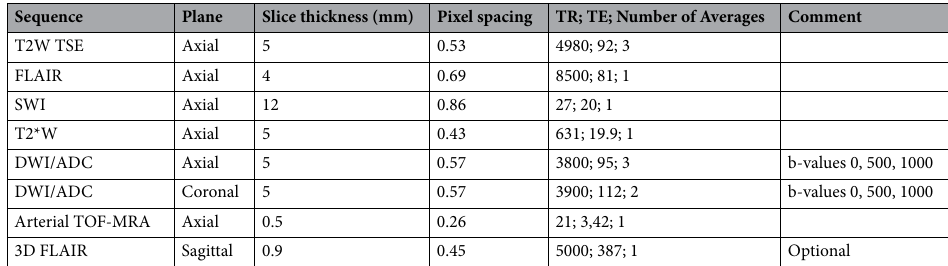
Table 1. MRI sequences for the late follow-up imaging. T2W T2-weighted, FSE fast spin echo, TSE turbo spin echo, FLAIR fluid-attenuated inversion recovery, SWI susceptibility weighted imaging, DWI diffusion- weighted imaging, ADC apparent diffusion coefficient, TOF-MRA time-of-flight